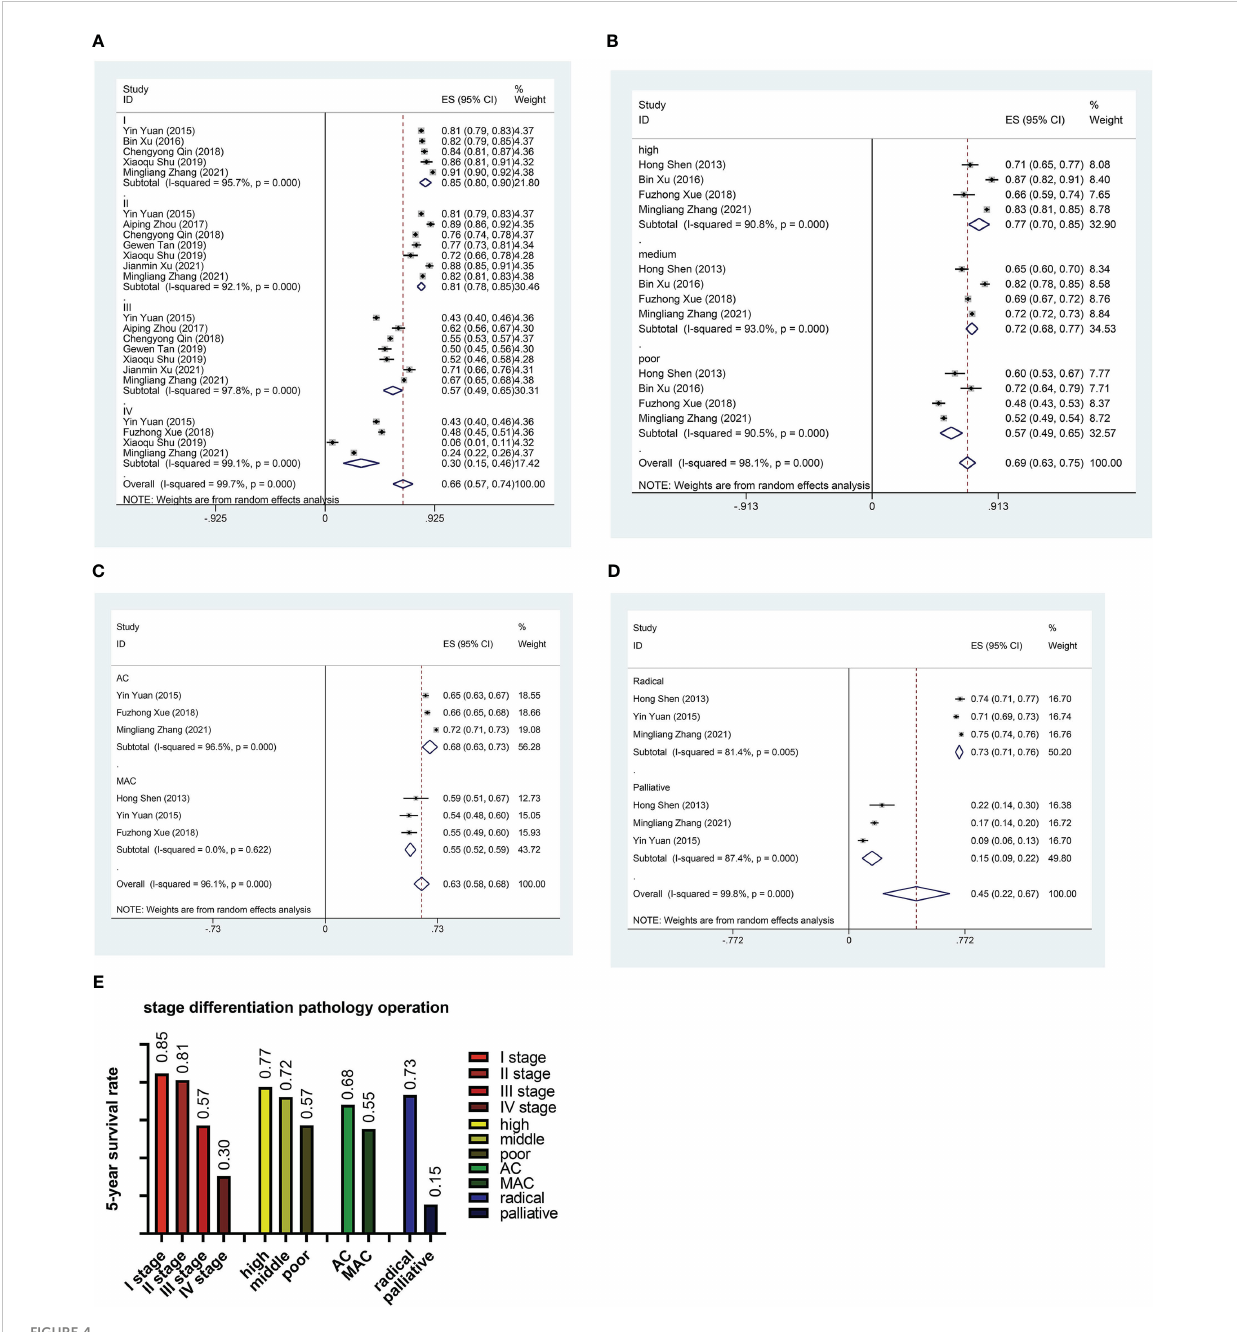
FIGURE 4 Subgroup analysis. (A) Forest plot of subgroup analysis based on stage. (B) Forest plot of subgroup analysis based on differentiation. (C) Forest plot of subgroup analysis based on pathological type. (D) Forest plot of subgroup analysis based on surgical method. (E) Histogram of subgroup analysis based on stage, differentiation, pathological type and surgical method. AC, Adenocarcinoma; MAC, Mucinous